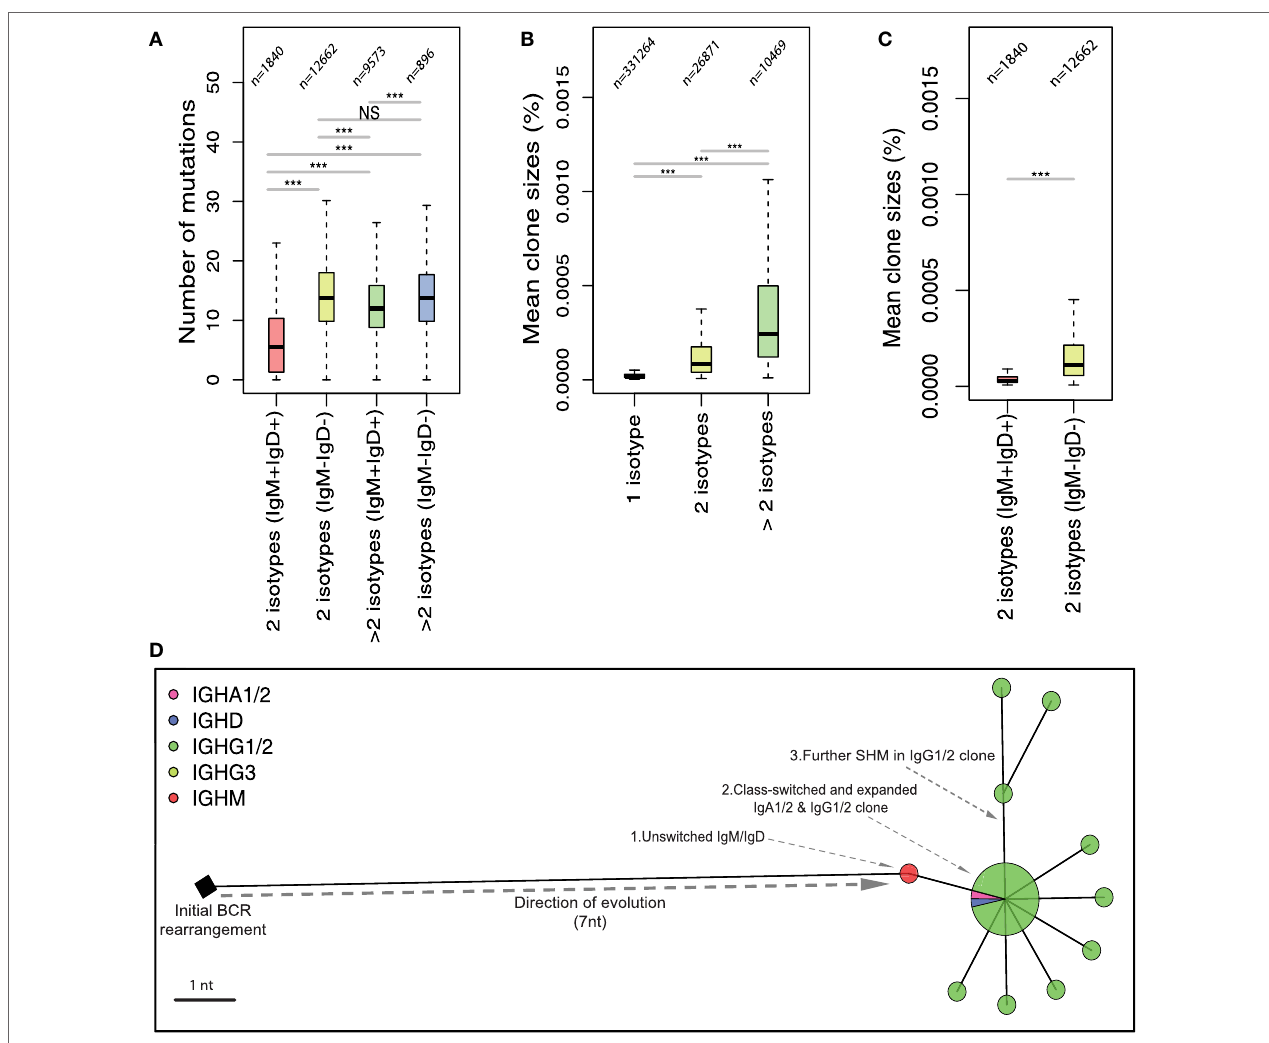
FigUre 2 | Relationship between somatic hypermutation and class-switching in the evolution of B-cell responses in healthy repertoires. Repertoires were clustered into networks of related B-cell receptors (BCRs) as previously described (33). (a) Boxplots of the mean number of mutations from germline in clones exhibiting 2 isotype classes or greater than 2 isotype classes that are either IgM + IgD + or IgM − IgD − . The y -axis represents the number of nucleotide mutations in IGHV genes of BCRs associated with the respective number of isotypes. (B) Boxplots of the mean size of BCR clones formed by the respective number of isotypes shown on the x -axis as a proportion of total BCR reads. (c) Boxplots of the mean size of clones exhibiting 2 isotype classes that are either IgM + IgD + or IgM − IgD − . Numbers above each boxplot in (a–c) represent the total number of clones considered for each isotype group. (D) A maximum parsimony tree of a class-switched BCR cluster in healthy repertoire representing an example of a clonal expansion following class-switching. *** p -value = 0.0005 and ** p- value = 0.005 (Wilcoxon rank-sum